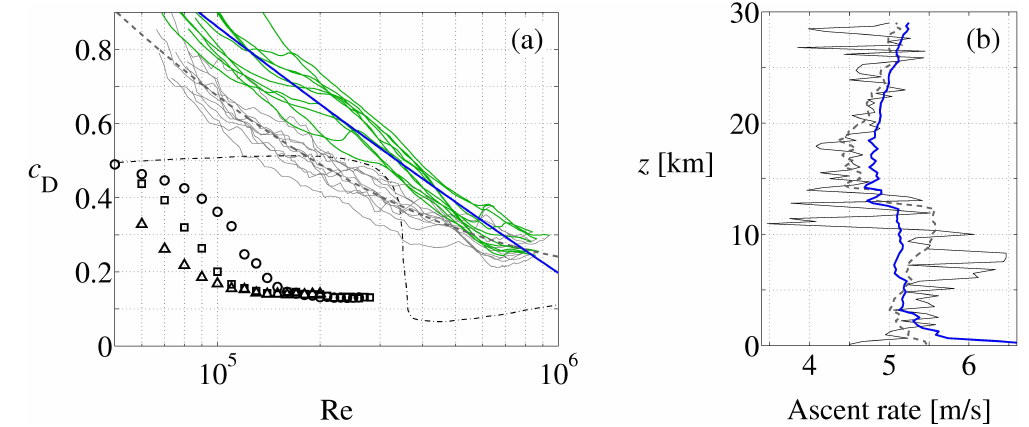
Fig. 10. Effect of the ten-fold increase of the mean molecular heat diffusion coefficient on the model. (a) Experimental drag curves derived from the ten LUAMI flights (—), and their associated reference drag curve (—), in the case of the enhanced h D i . The ten experimental curves ( —) and the reference drag curve (–––) pictured in Fig. 3 are reported here for comparison, along with the curves by Achenbach (1972) and Son et al. (2010) for a perfect sphere. (b) Vertical profile of the balloon ascent rate in still air calculated from the corrected reference drag curve in the case of LUAMI flight L003b (see Fig. 6); h D i increased by a factor of ten (—); h D i normal (–––). The 60-s low pass filtered vertical profile of the ascent rate calculated from the GPS data is indicated here for comparison